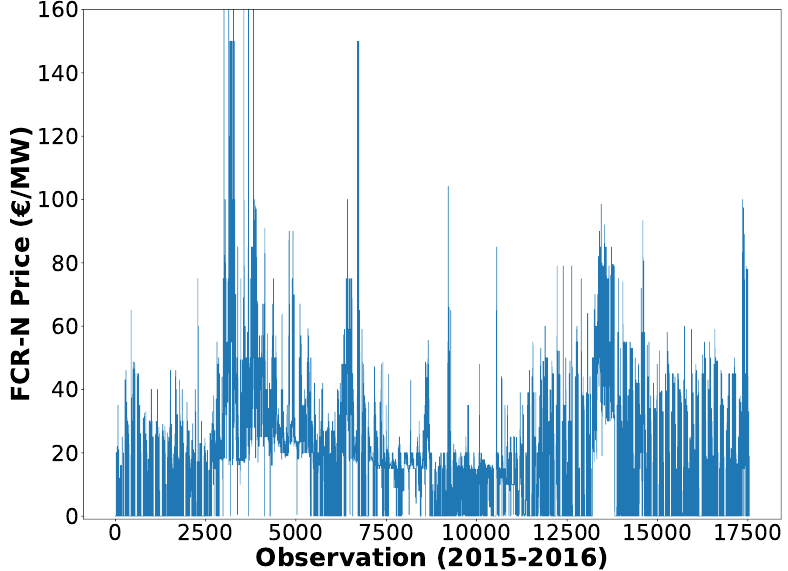
Figure 1. Two years if data collected for the FCR-N market prices, limited to a maximum value of 160 €